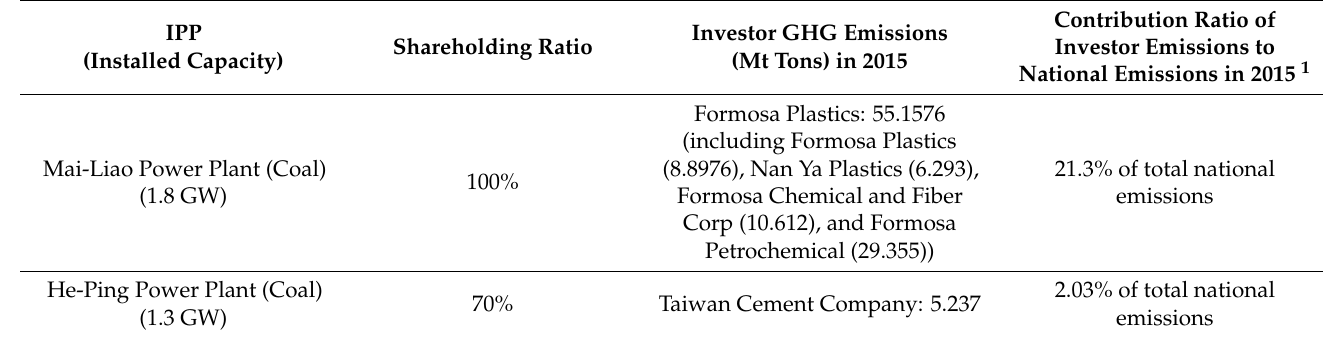
Table 1. Taiwan’s IPP investors and their overall contributions to national GHG emissions.